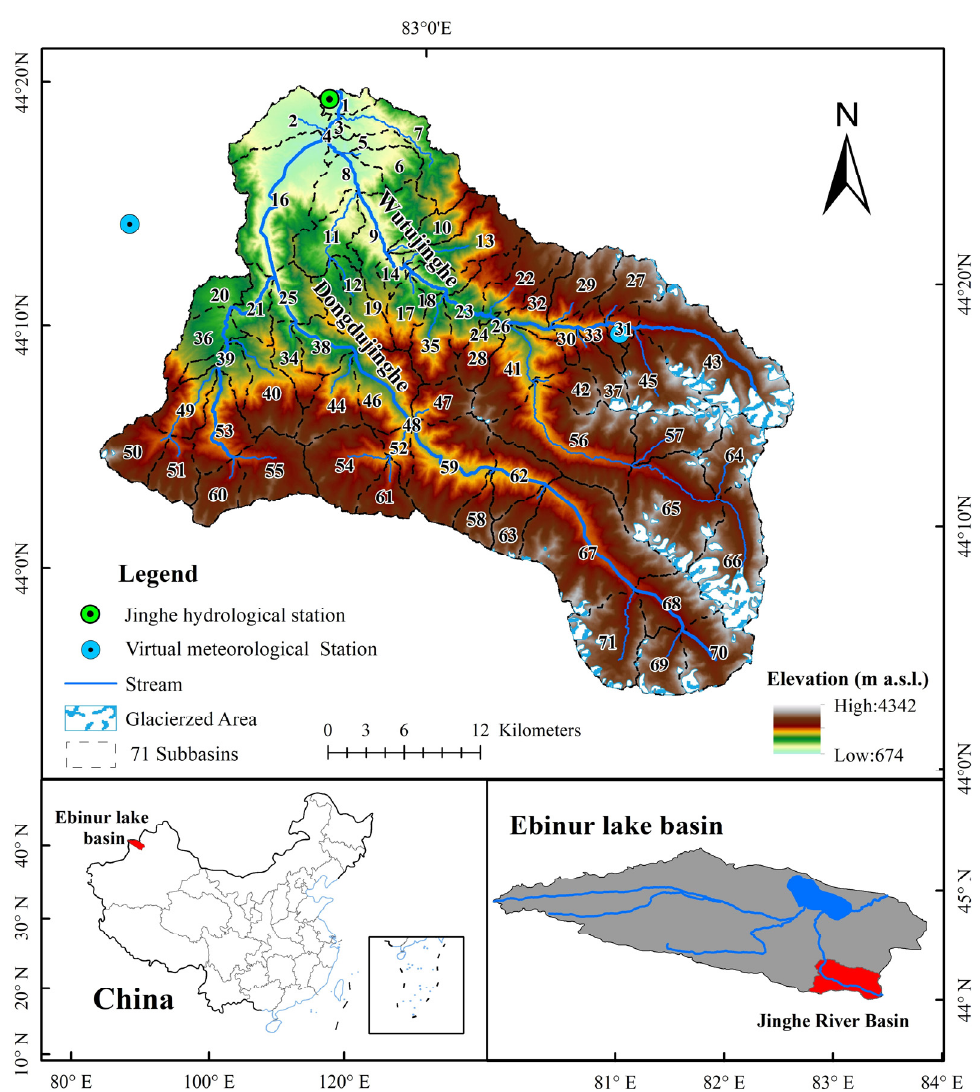
Figure 1. Location of the Jinghe River Basin and the distribution of glaciers.